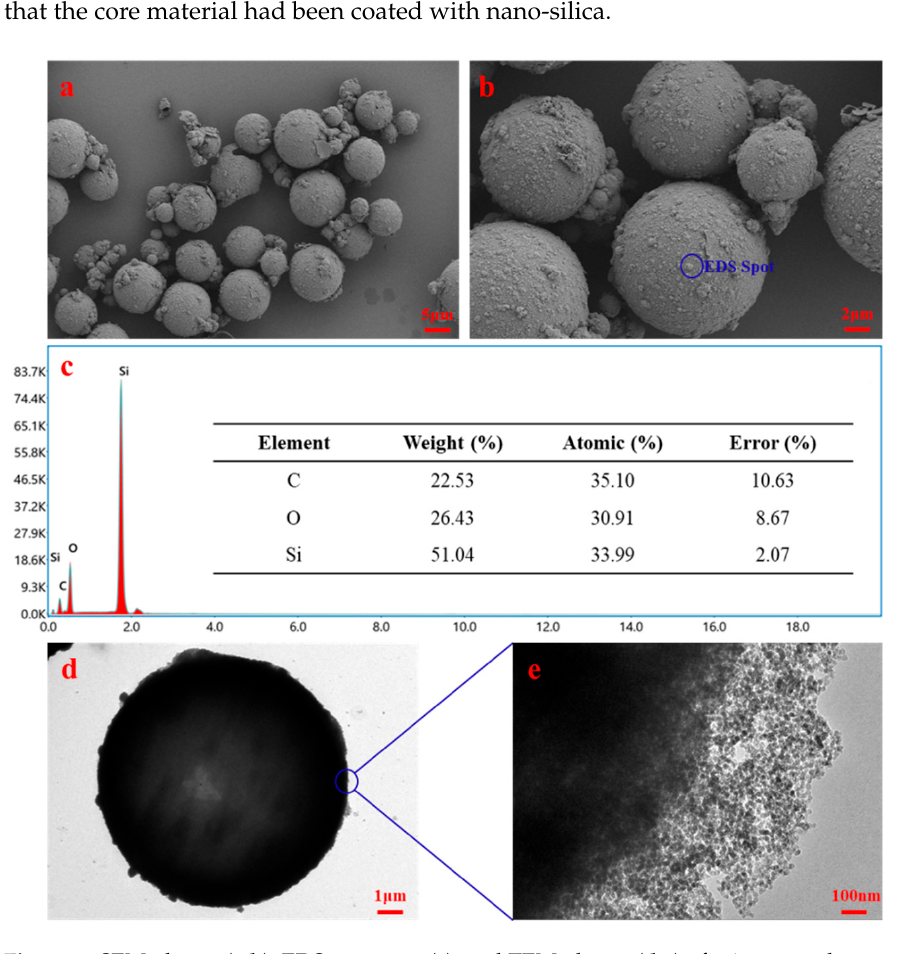
Figure 5. Particle size distribution of microcapsules in deionized water. 0.01